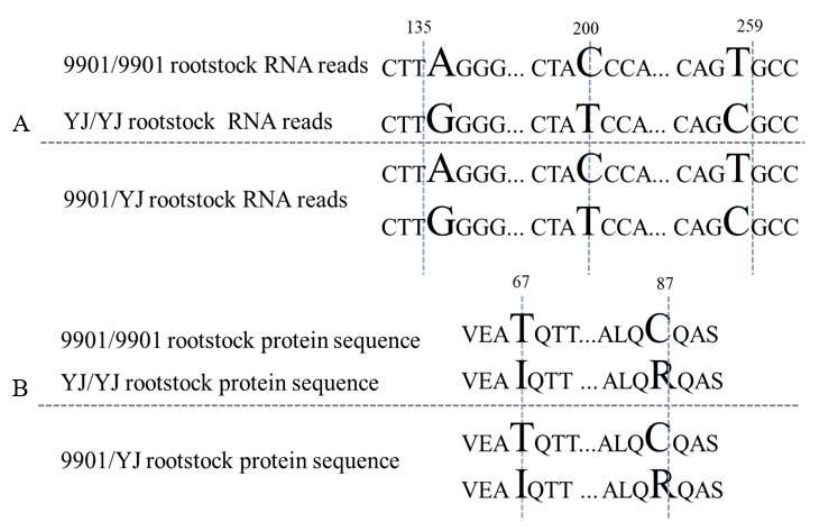
Figure 5. SNP analysis of the ABF2 gene (K14432) in the rootstock of 9901/YJ. ( A ), nucleotide; ( B ), amino acids.